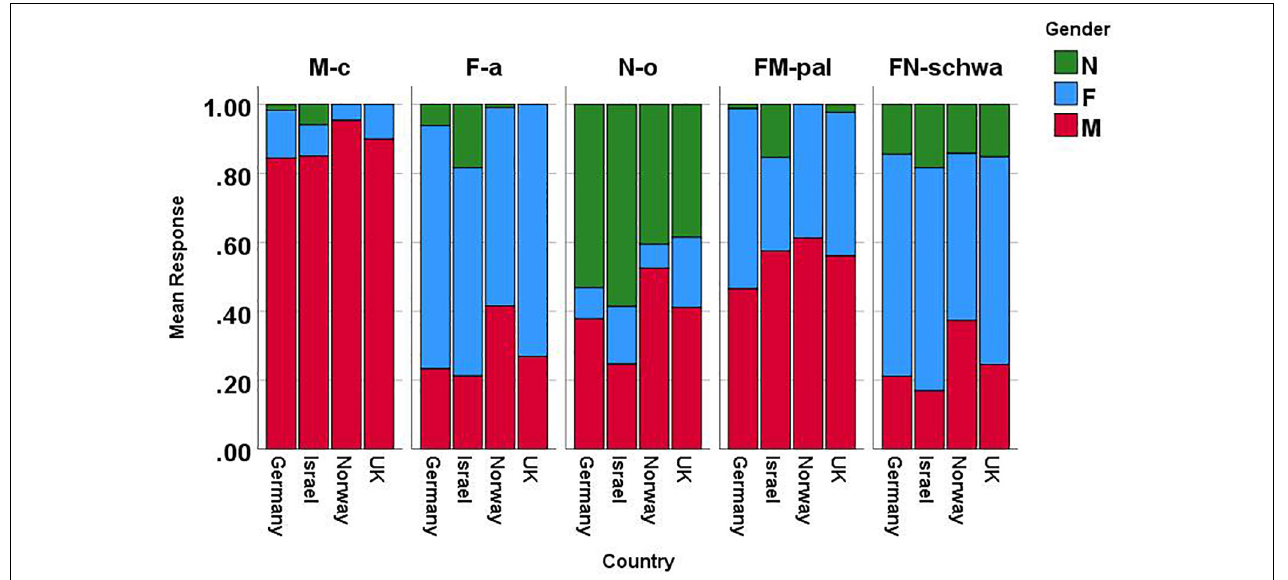
FIGURE 2 | Performance on nonce words per condition per